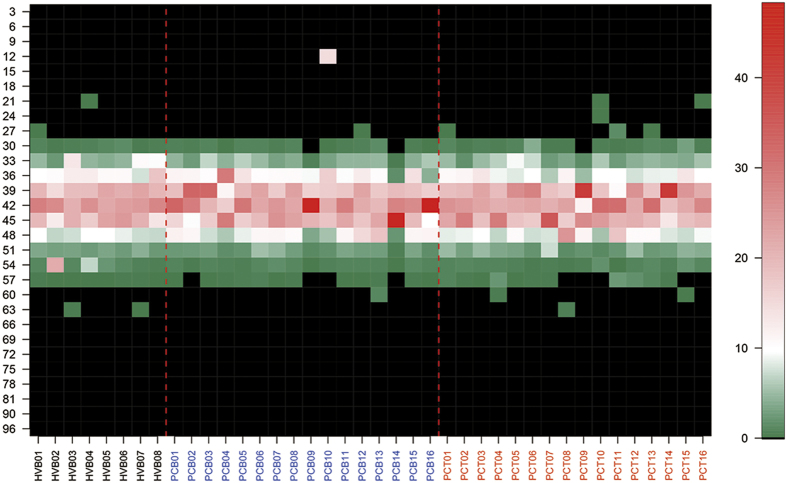
Complementary determining region 3 (CDR3) length usage difference was not detected in groups.The median lengths were 42 base pairs and normal distribution was found in all three groups.